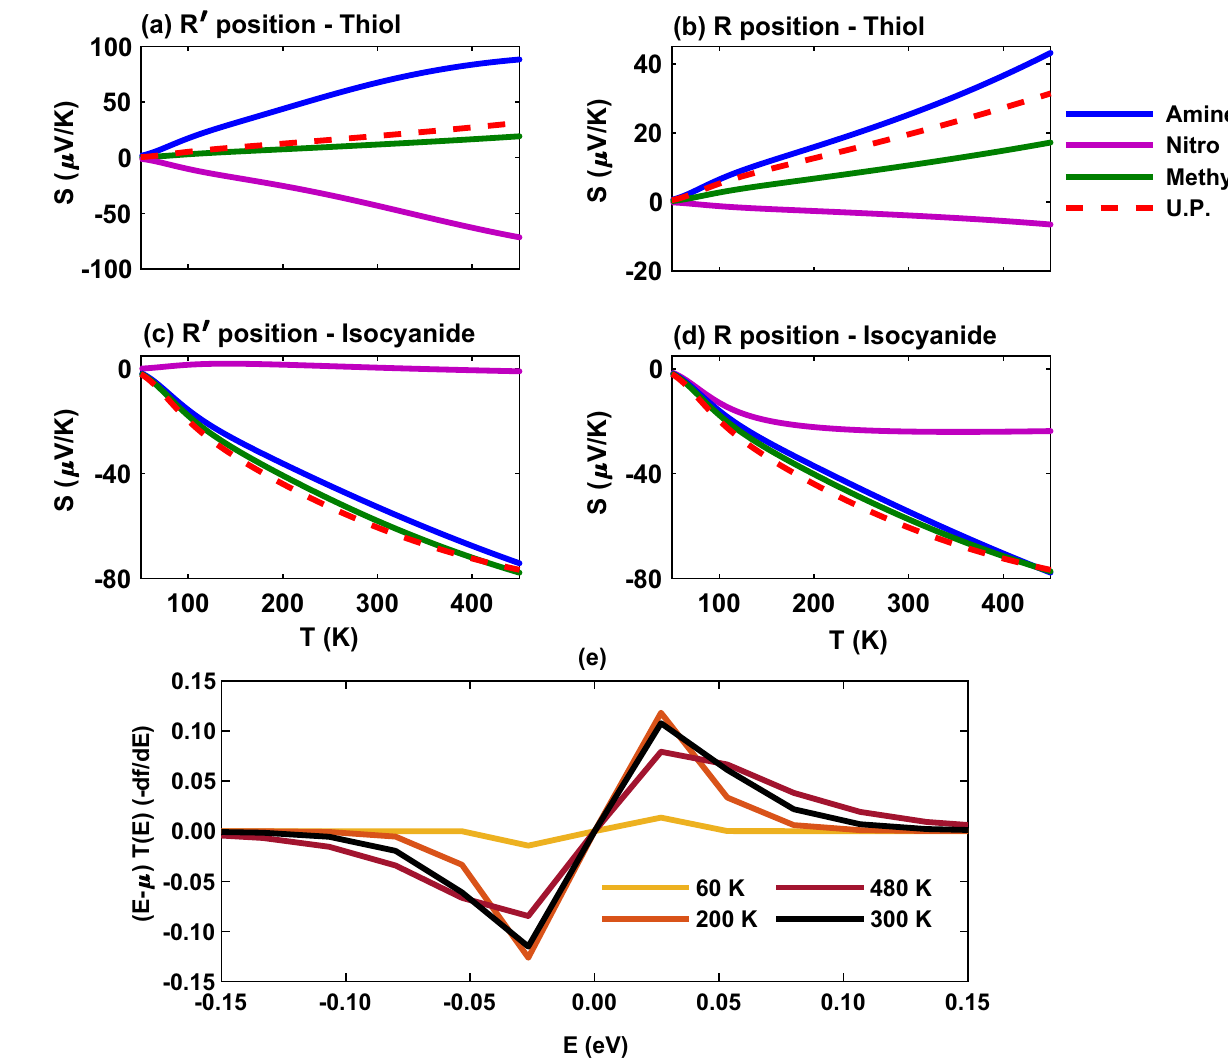
Figure 9. The thermopower of the Au-anthracene-Au junction versus temperature when the molecule- electrode contact in mediated by the thiol anchoring unit in the presence of amine (blue), nitro (magenta) or methyl (green) as the side group in ( a ) R ′ and ( b ) R positions. The electrical conductance of the isocyanide- terminated junction with amine (blue), nitro (magenta) or methyl (green) side group in ( c ) R ′ and ( d ) R positions. Also, the thermopower of the unperturbed (U.P.; red) system in the absence of side groups is drawn as a reference. ( e ) (ε − µ) T (ε)( − df / d ε) is drawn for the isocyanide-terminated junction with nitro side group in the R ′